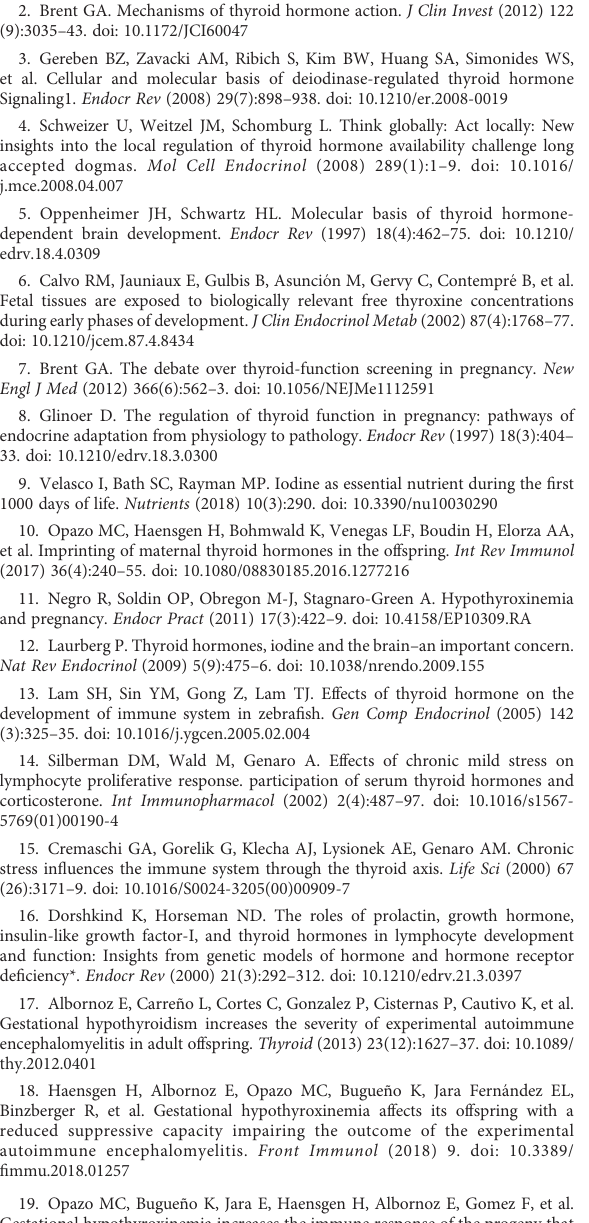
SUPPLEMENTARY FIGURE 6 Gestation under hypothyroxinemia did not alter the levels of in fl ammatory cytokines in the lung seven days after infection with hMPV. Using qPCR, the expression of the cytokines IL-6 (A) , IFN- g (B) and IL-10 (C) in the lung on day seven post-infection was determined. Values were presented based on expression relative to the b -actin reference gene. Two-way ANOVA and Tukey ’ s multiple comparisons test were